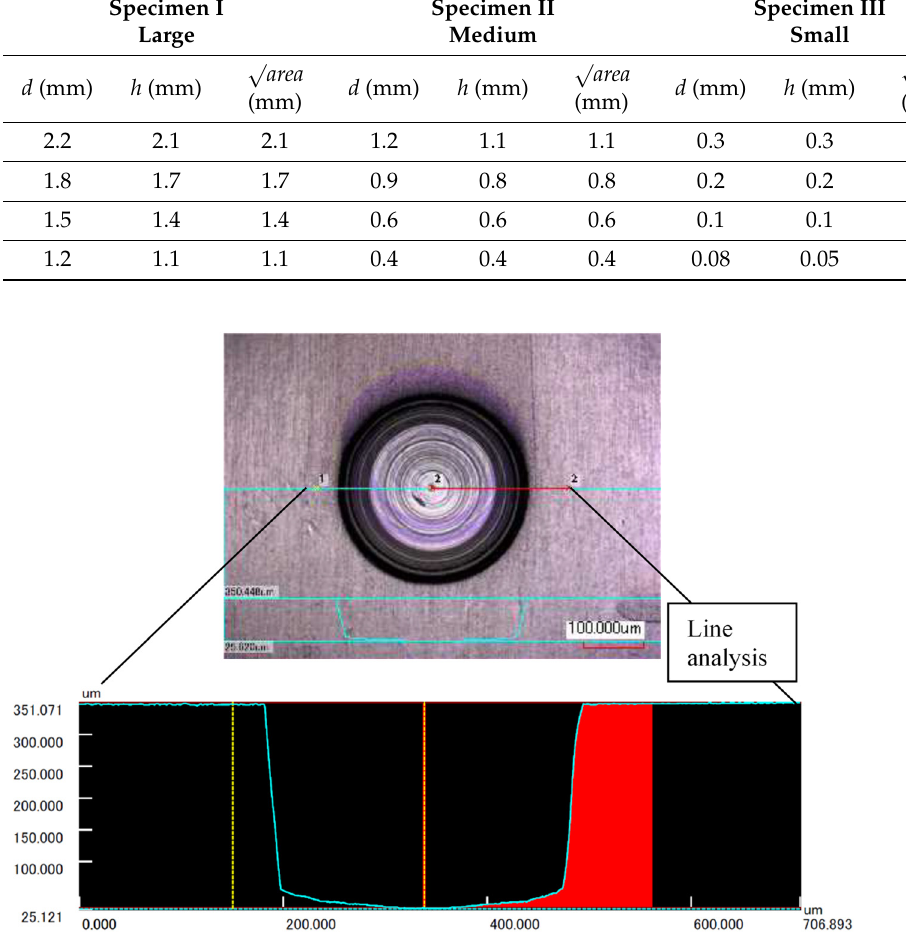
Figure 2. An example of the shape of a hole defect measured by an LSM.